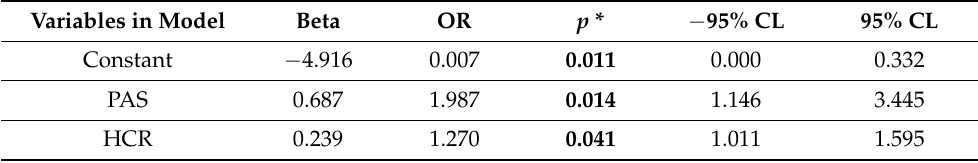
Table 4. Results of stepwise regression analysis for dependent variable pneumonia—variables in the model.